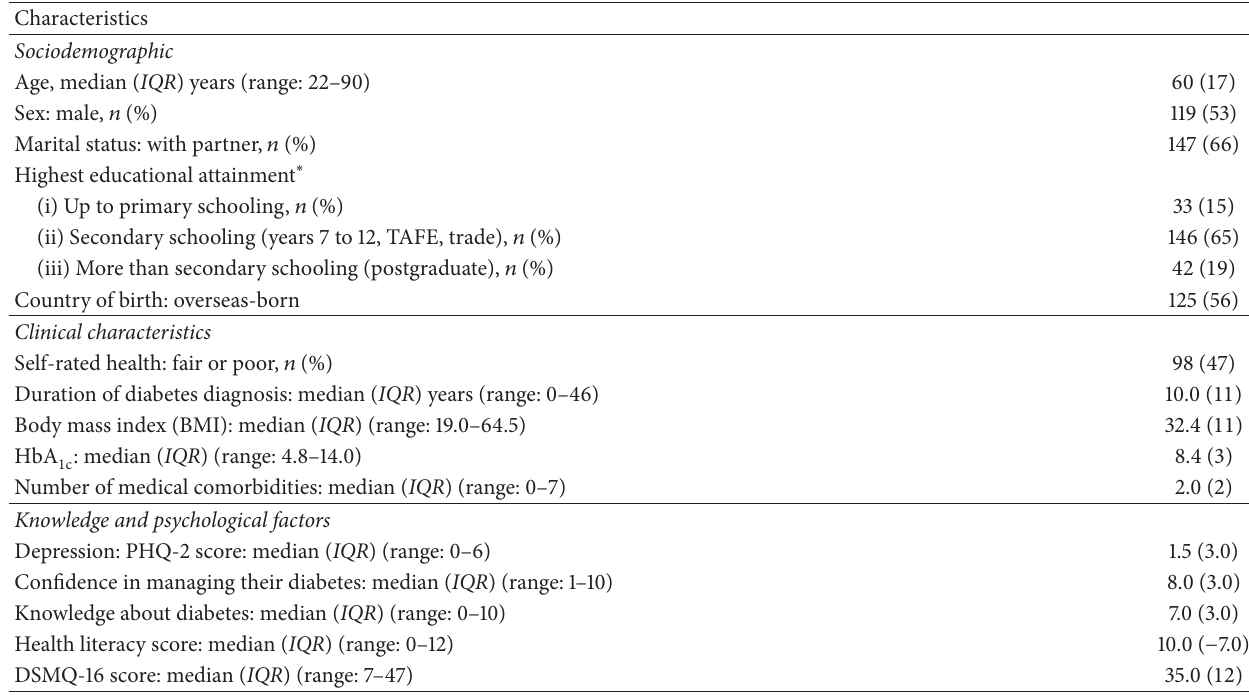
Table 1: Characteristics of T2DM participants ( 𝑛 = 224 ).